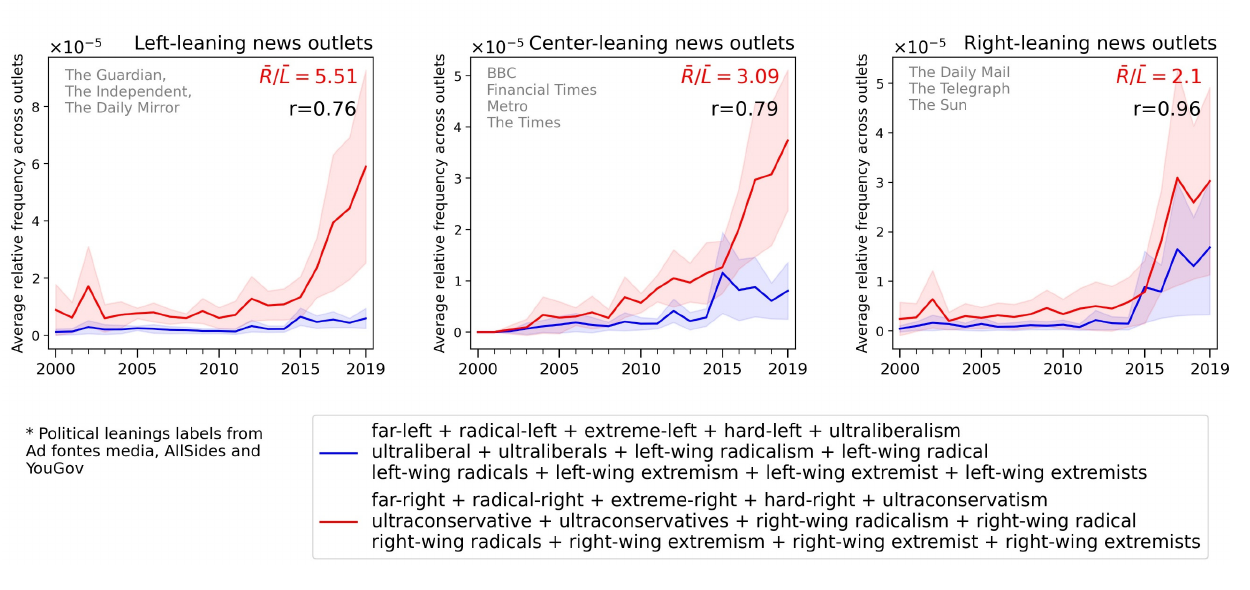
Figure 3. Average yearly prevalence of an aggregate set of terms denoting far-right (red) and far-left (blue) political extremism in 10 popular U.K. news media outlets arranged by outlets’ ideological leanings according to human ratings from AllSides Media Bias Chart 2019 v1.1, Ad Fontes Media and YouGov (AllSides 2019; Andrew McGee 2021; YouGov 2021). Shaded areas indicate the 95% confidence interval around the mean. The average prevalence ratio between both time series ( R / L or L / R ) is color-coded according to which ratio is dominant. The Pearson correlation coefficient, r, between the time series is shown on the top right of each subplot.